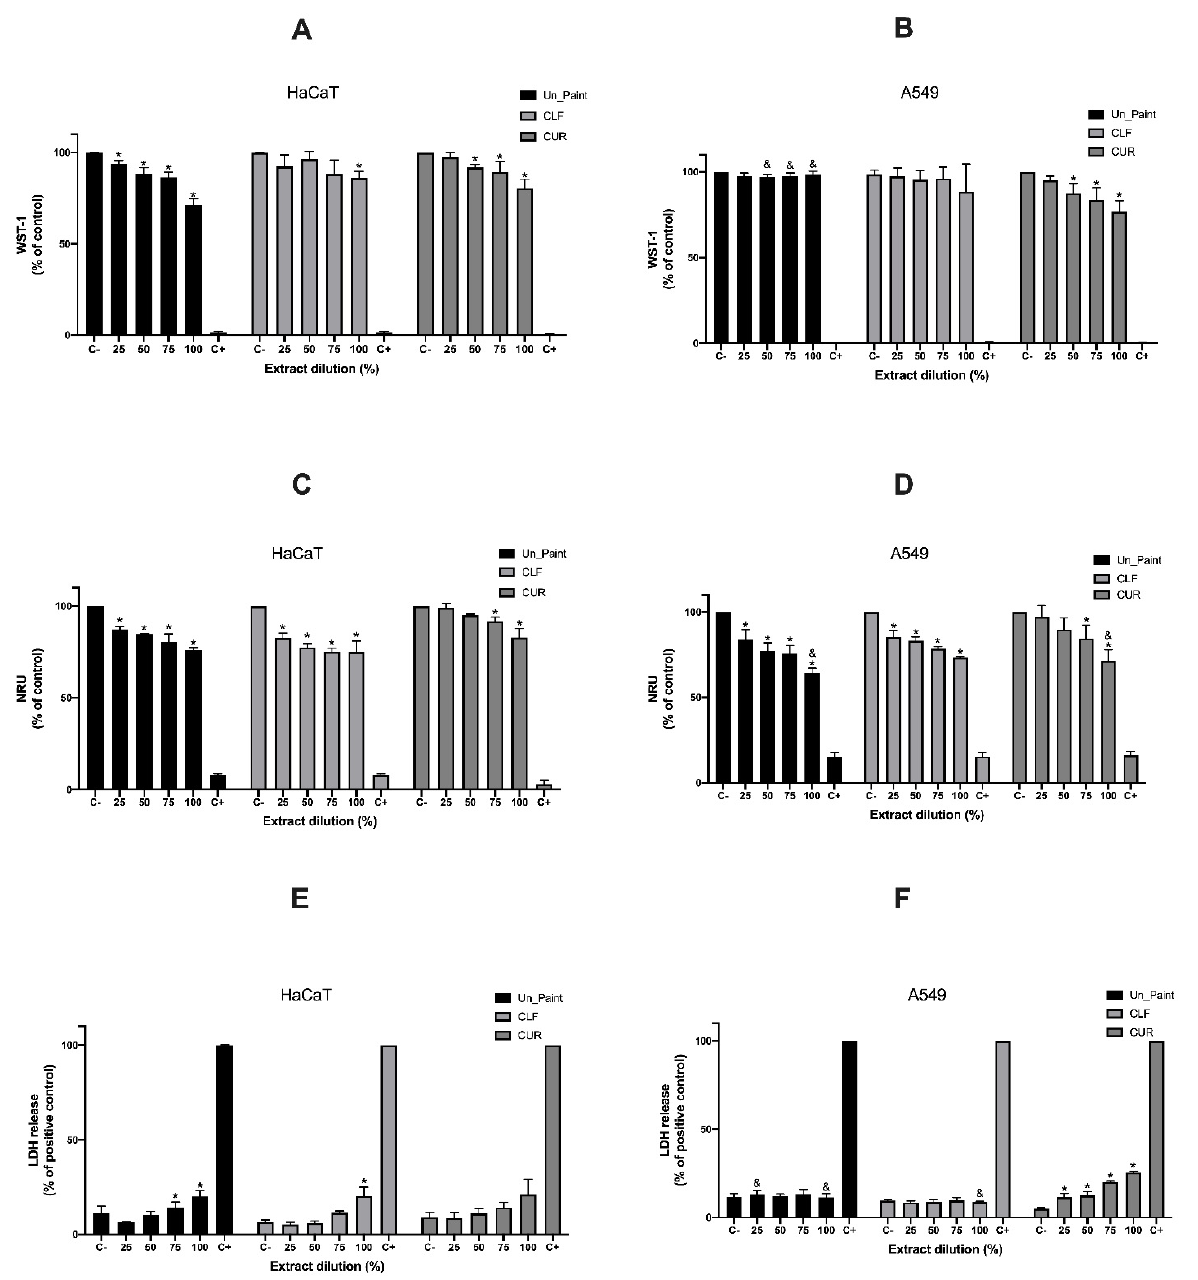
Figure 2. Results of WST-1 ( A , B ), NRU ( C , D ), and LDH ( E , F ) assays, with HaCaT and A549 cells, after 24 h incubation with CLF or CUR extracts at concentration of 25, 50, 75 and 100%. C-: negative control, C+: positive control. The values are expressed as mean ± standard deviation. The statistical significance of samples compared with C- is represented by *. (One-way ANOVA; p < 0.05). The statistical significance of A549 compared with HaCaT is represented by & . (Two-way ANOVA; p < 0.05.)